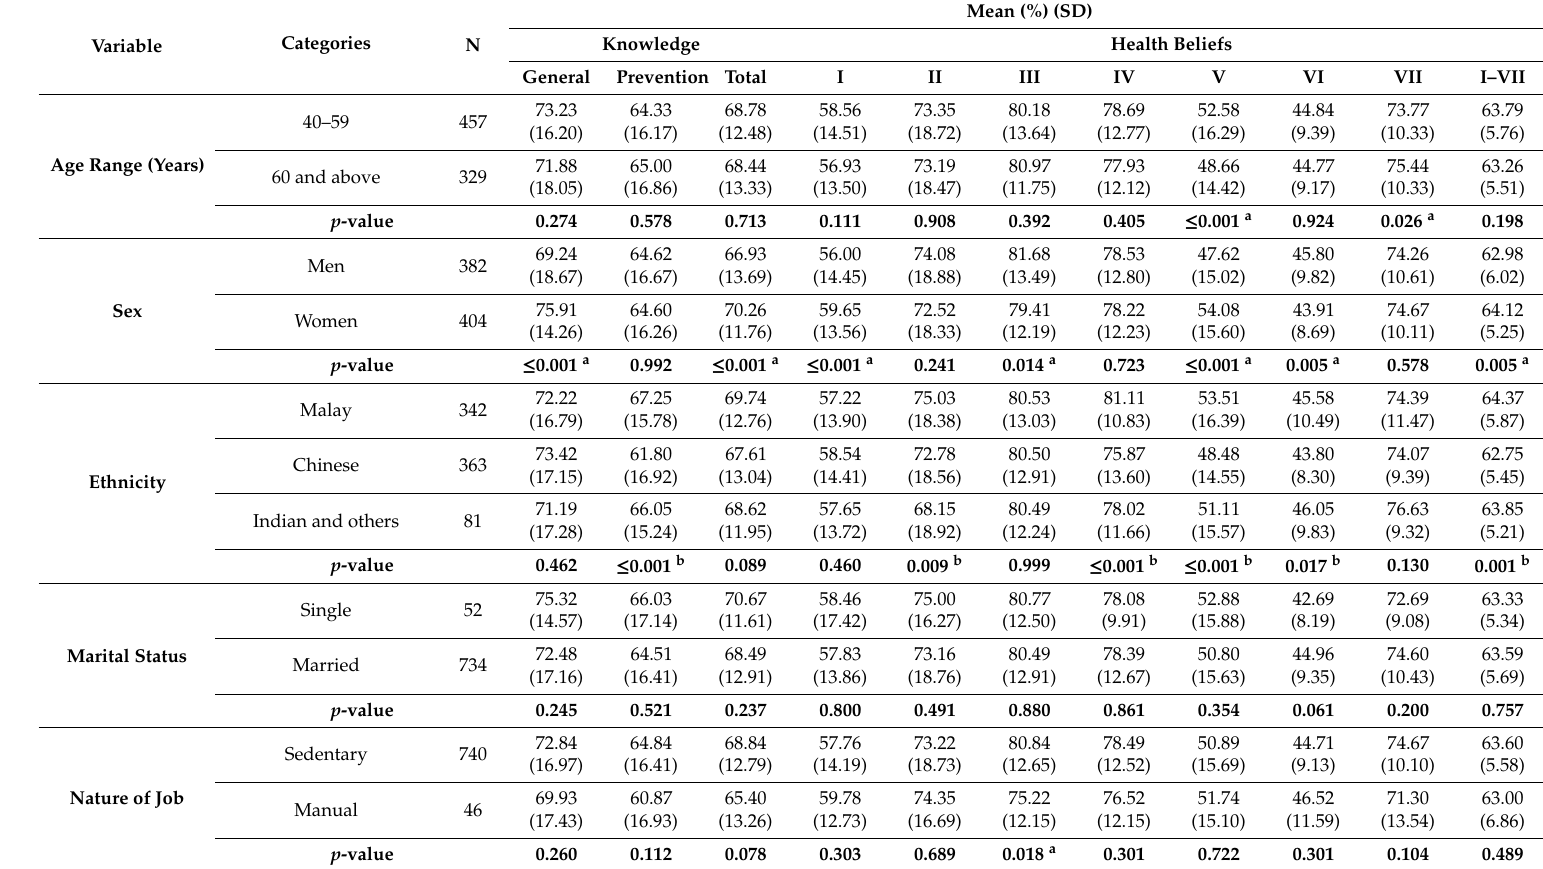
Table 3. Comparison of osteoporosis knowledge and beliefs with sociodemographic